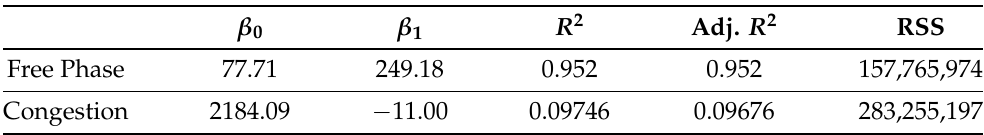
Table A2. RSS analysis with two clusters with flux and occupancy. β 0 is the value of the intercept and β 1 the